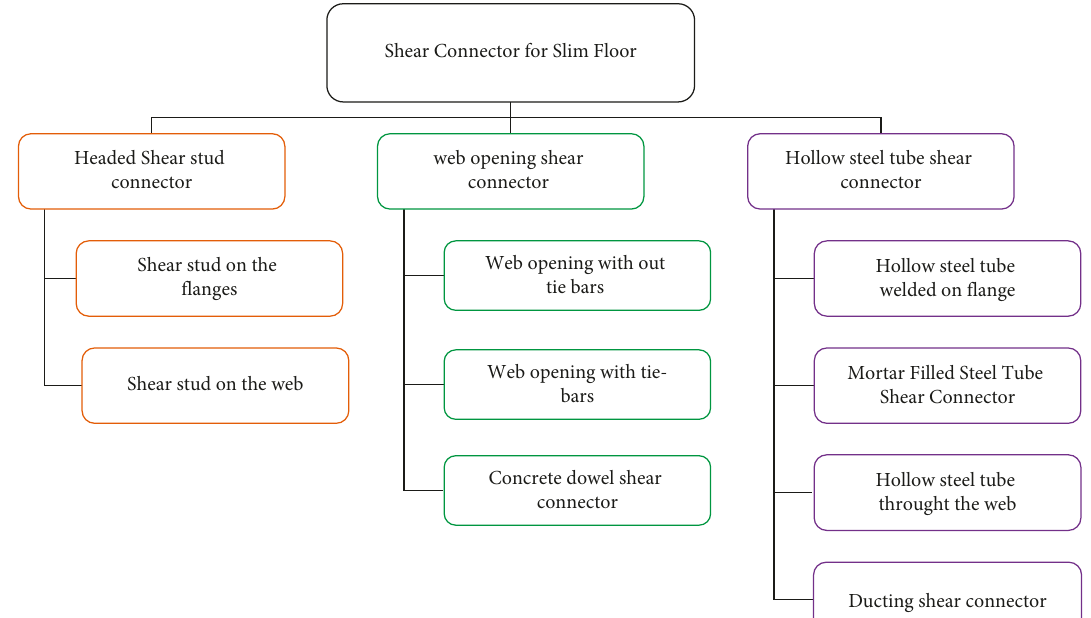
Figure 7: Types of shear connectors used in the composite slim floor beam.